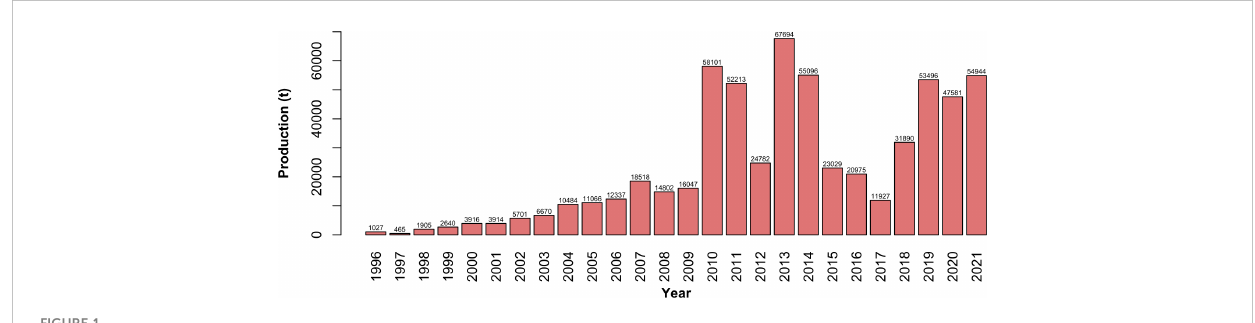
FIGURE 1 Production of A. purpuratus from aquaculture in Peru, during the period 1996 to 2021 (Cavero and Rodr ı ́ guez, 2008; PRODUCE, 2015; PRODUCE, 2020; PRODUCE, 2021; PRODUCE, 2022). The production of A. purpuratus had an important growth since 2010, however, due to extraordinary events, such as the El Nino phenomenon, ˜ in 2012 and during the period 2015-17, the production declined signi fi cantly. The production remains sustained in the last years despite environmental